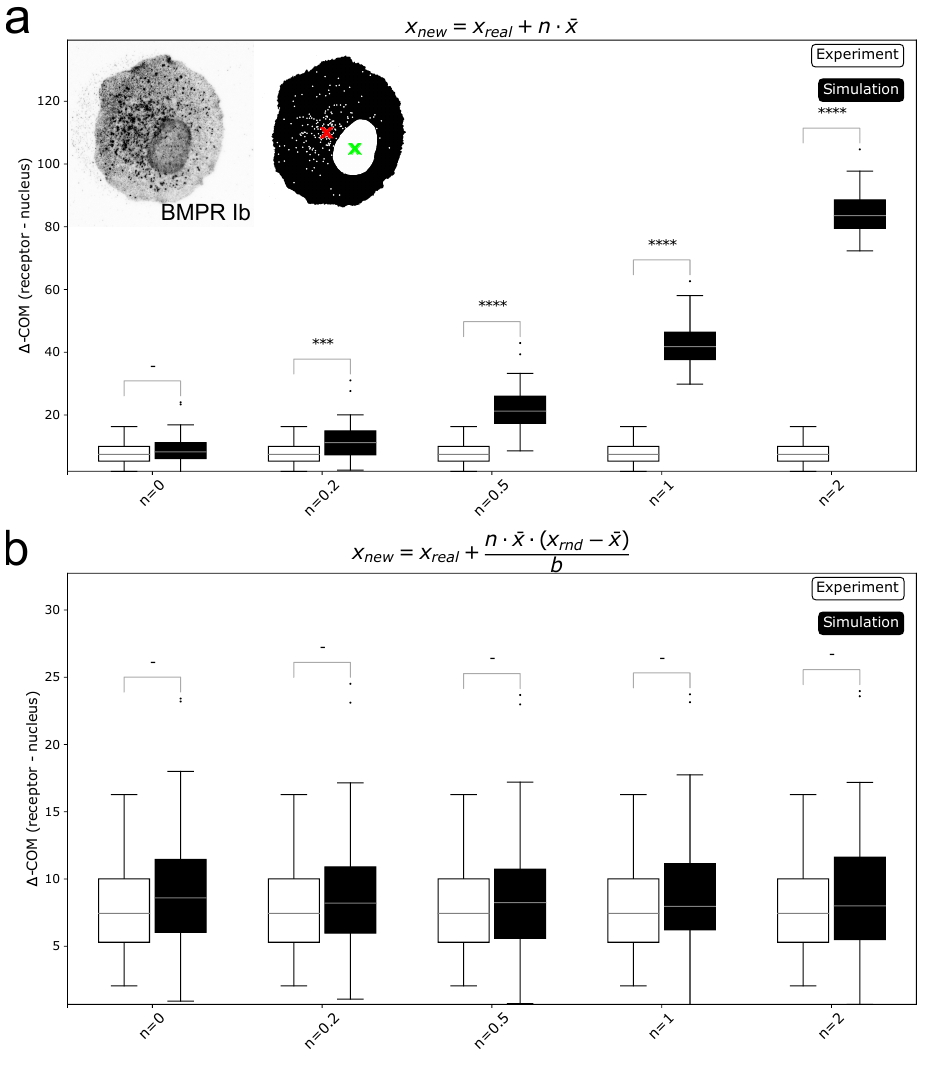
Figure 3. Comparison of simulated and experimental data for reference metric. ( a ): Simulations of a shift in distributions ( x new = x real + n · ¯ x ). All tested values for n > 0 showed significant differences. n · ¯ x · ( x rnd − ¯ x ) ( b ): Simulations of a spread in distributions ( x new = x real + ). Here, for all values of b n no significant differences were found. Reference metric is sensitive to shifts in COM position, but not to differences in spread of distributions. *** = p < 0.001, **** = p < 0.0001, - = not